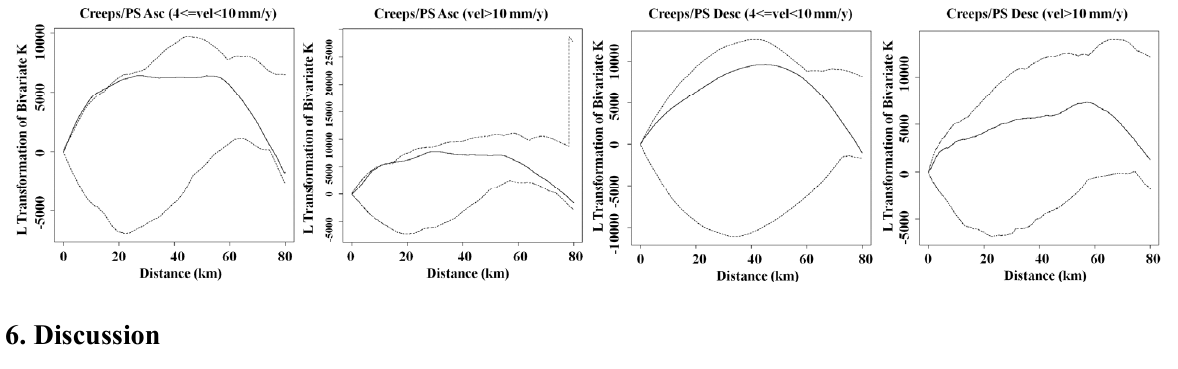
Figure 6. The result of the bivariate K-function analysis for evaluating spatial relationships between PS and occurrences of creeps throughout the Arno River basin. Dashed lines are 98% confidence intervals and solid lines are the observed